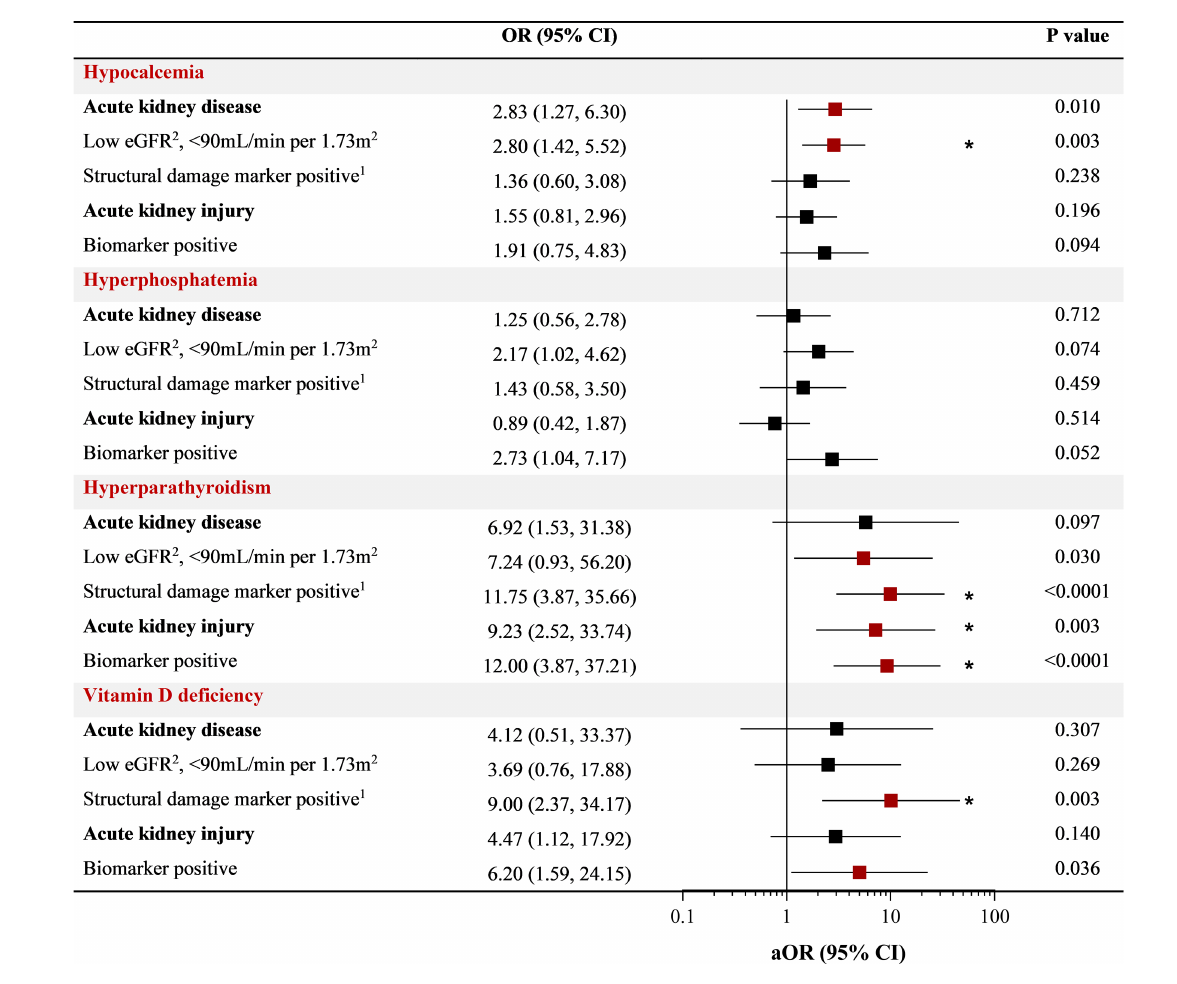
FIGURE 4 Relationship between kidney function and individual markers of mineral metabolism. Forest plot depicting the odds ratio (OR) and 95% CI between individual abnormalities in bone mineral metabolism (hypocalcemia, hyperphosphatemia, hyperparathyroidism, vitamin D de fi ciency) and measures of kidney disease using logistic regression. The adjusted OR (aOR) adjusts for participant age and sex with relationships with a p <0.05 in red and an asterisk indicating relationships signi fi cant after adjusting for multiple testing at an adjusted alpha of 0.01 within each mineral abnormality category